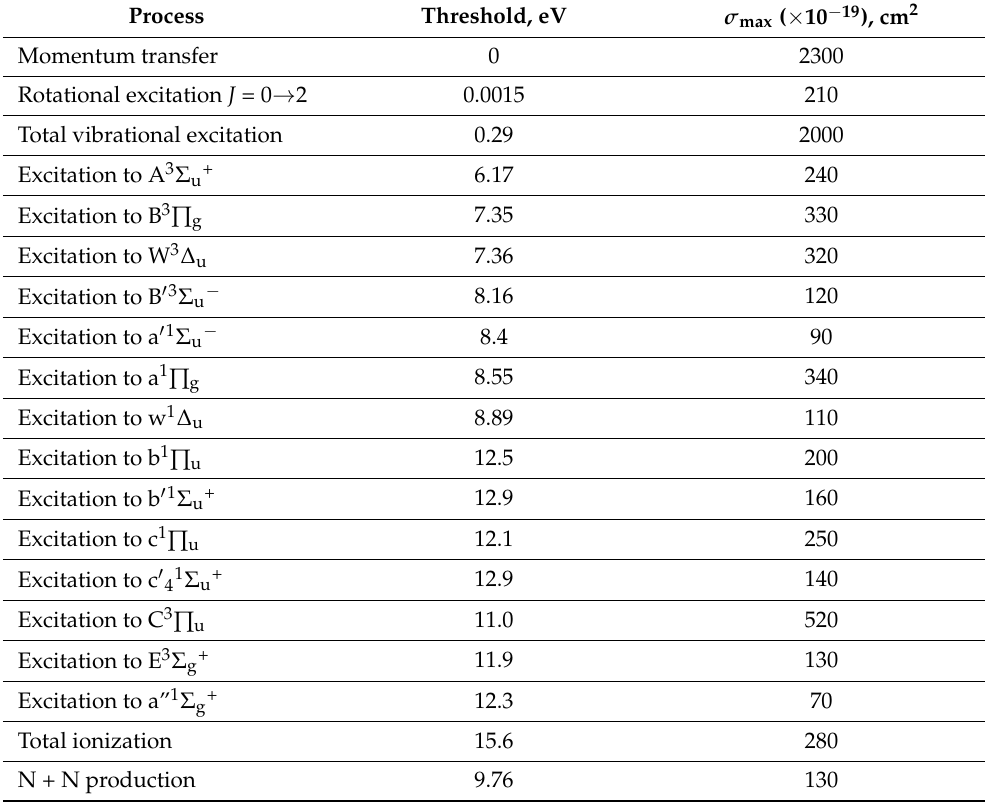
Table A1. Electron impact on N 2 .